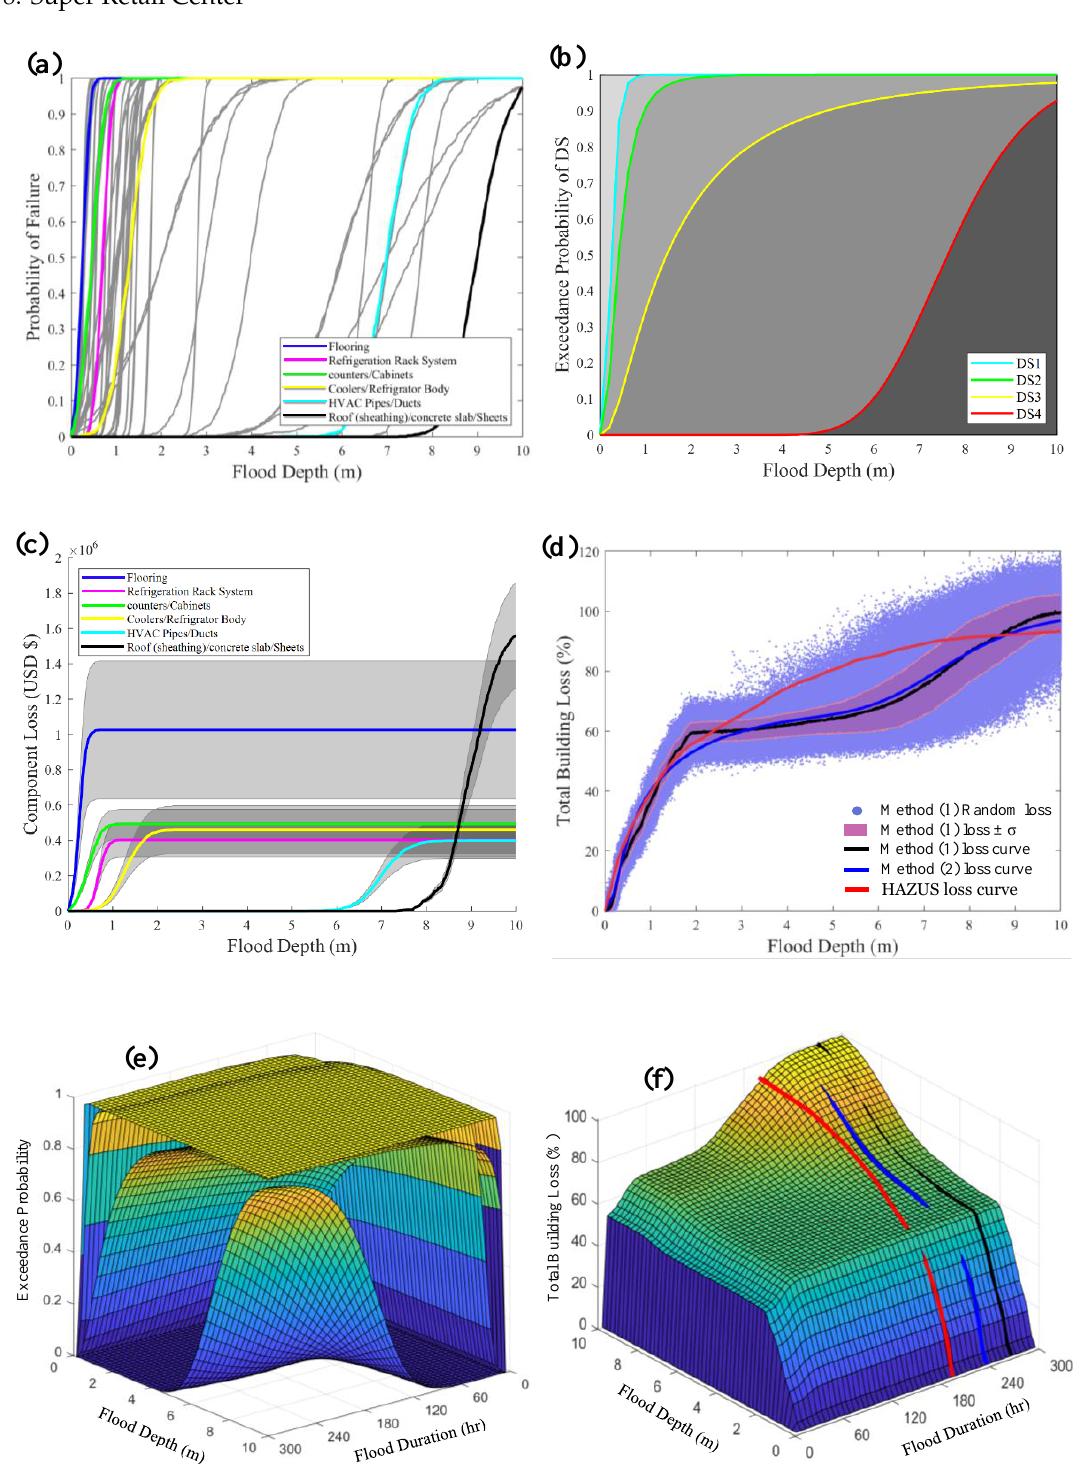
Figure A22. F8 archetype analysis results: ( a ) Component fragility curves; ( b ) Building fragility curves; ( c ) Selected components’ loss curves; ( d ) Building loss curves; ( e ) Building fragility surfaces; ( f ) Building loss surface.